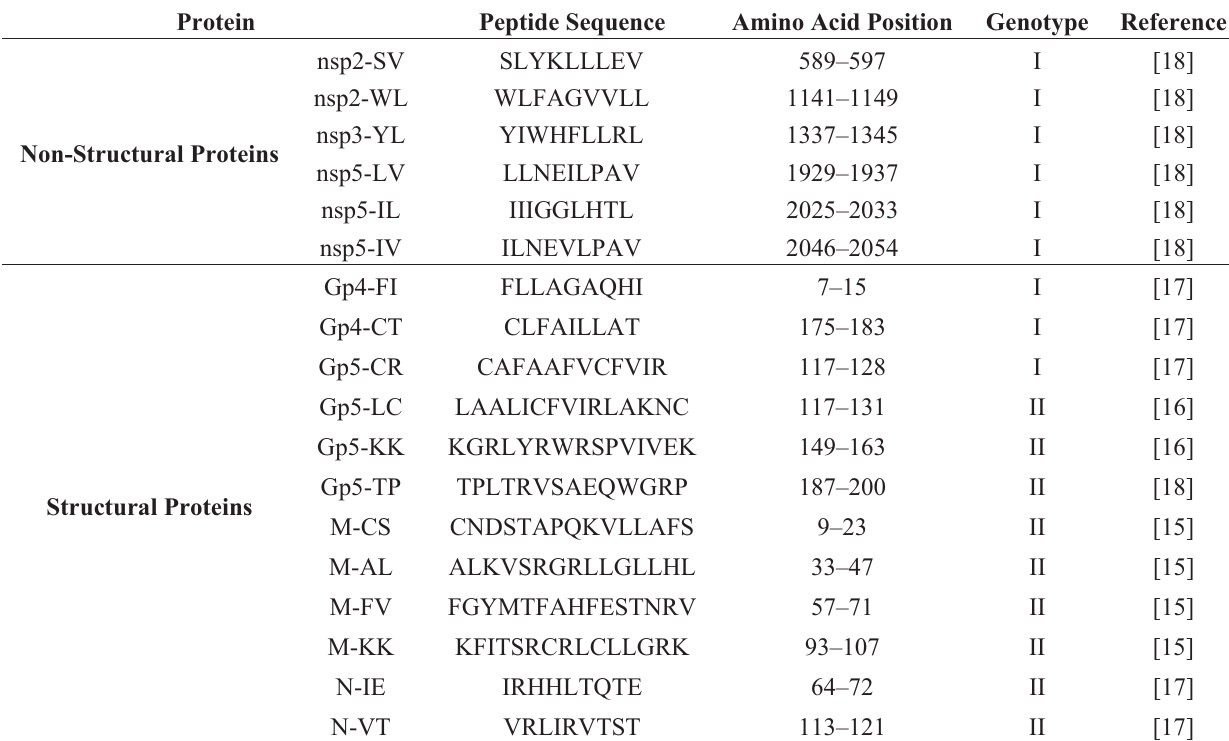
Table 3. Peptides used in this